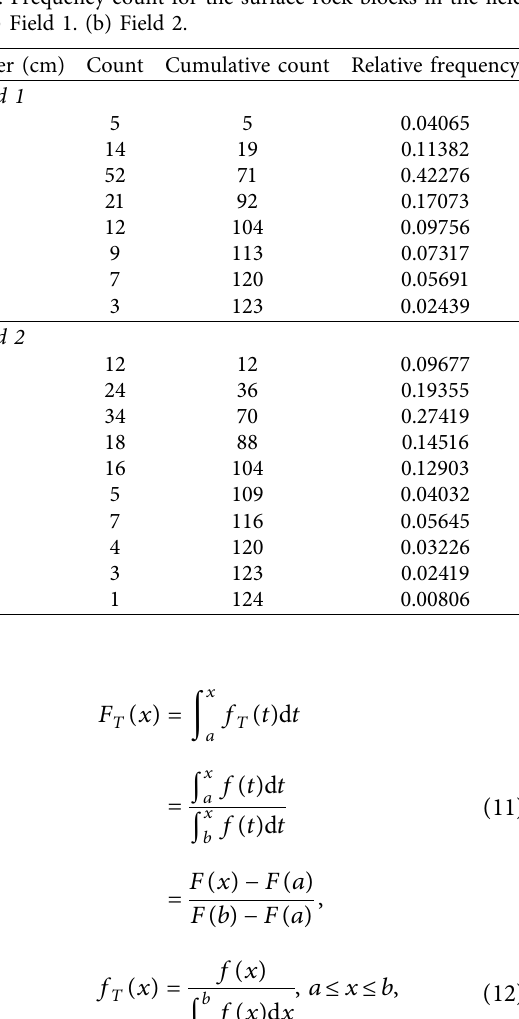
Figure 13: Stacked blocks with different arrangements in the filed experiments. (a) Test 1. (b) Test 2. Table 3: Frequency count for the surface rock blocks in the